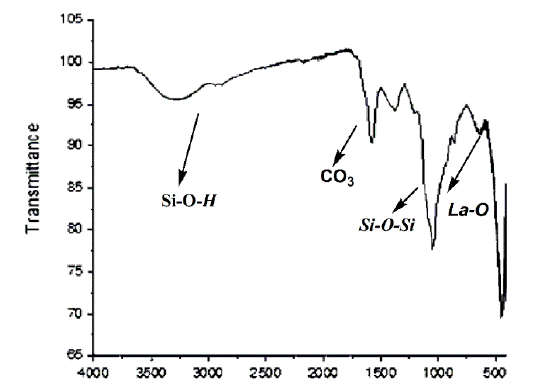
Figure 2. ATR-FTIR spectra of La(III)O-KIT-6 after three cycles of reaction. The XPS (X-ray photoelectron spectroscopy) spectrum of support (Figure 3, left) showed the expected main components, Si and O, with a little C contamination (ca. 5 at. %). Instead, the spectrum of the catalyst ( 2) was dominated by the peaks of lanthanum (Figure 3, right), indicating that the rare